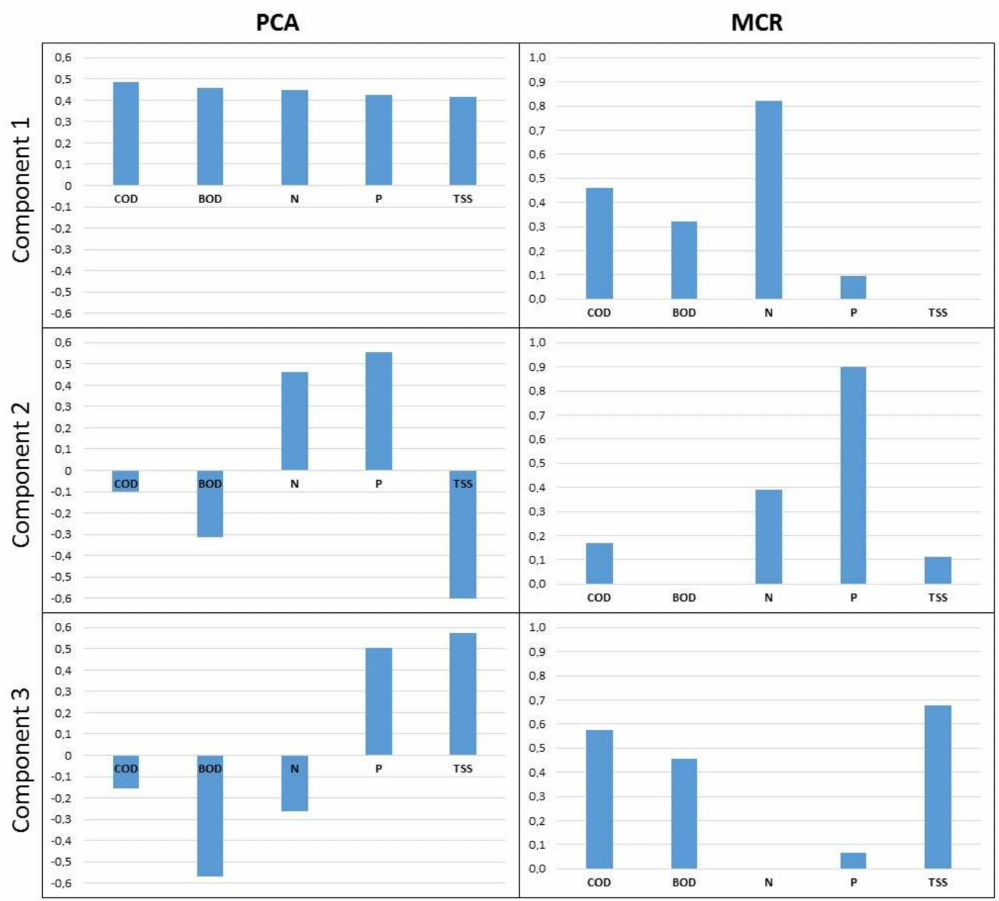
Figure 1. Principal component analysis (PCA) and multivariate curve analysis (MCR) component loadings.